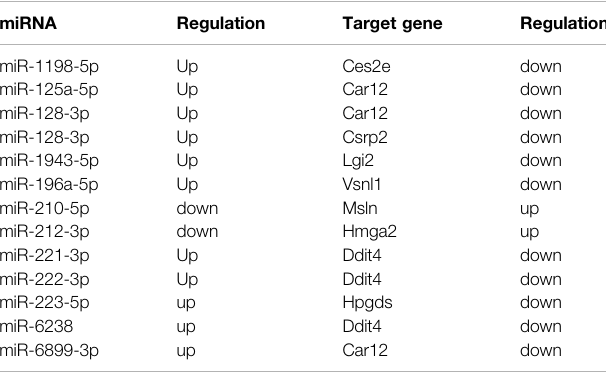
TABLE 3 | miRNA/mRNA axes screened out by bioinformatics analysis.